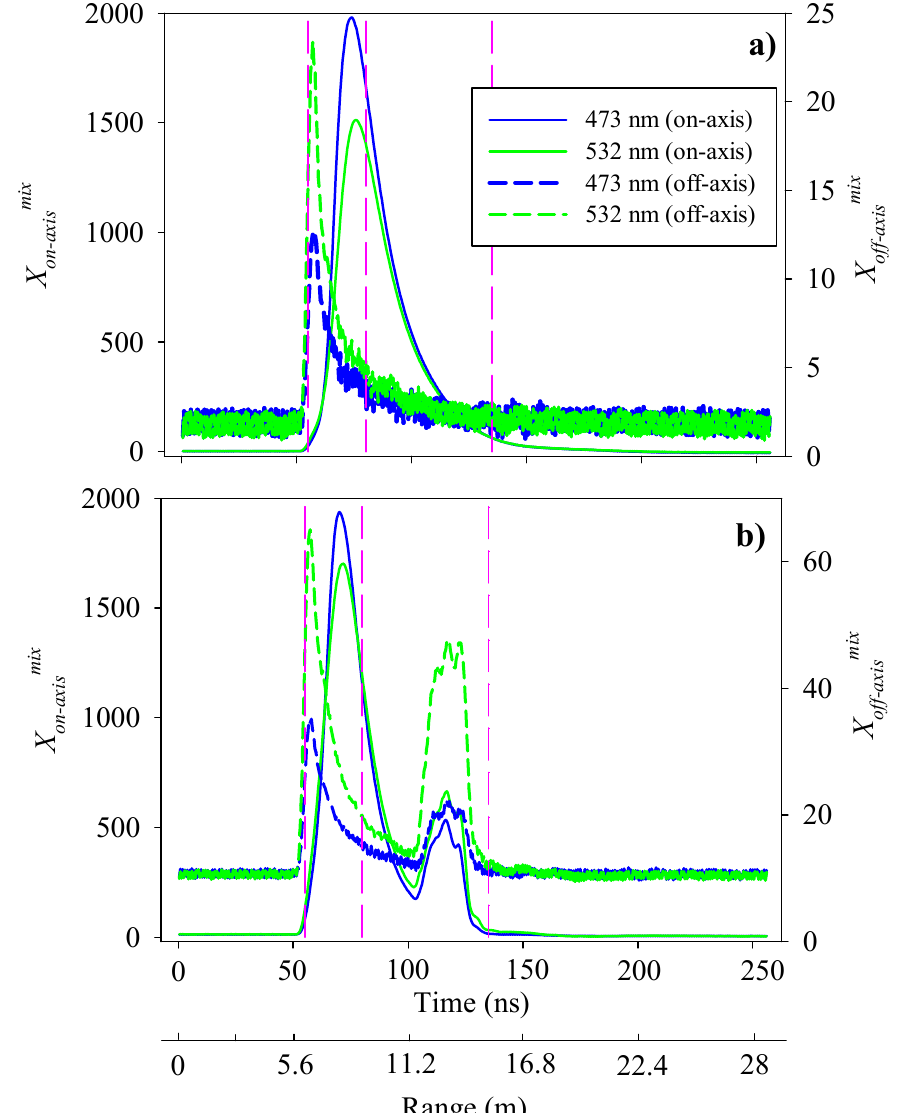
Figure 3. Mean range-resolved waveforms per capture. ( a ) 9:36 a.m., ( b ) 12:58 p.m. Time bins 110, 160 and 270 (vertical magenta lines).